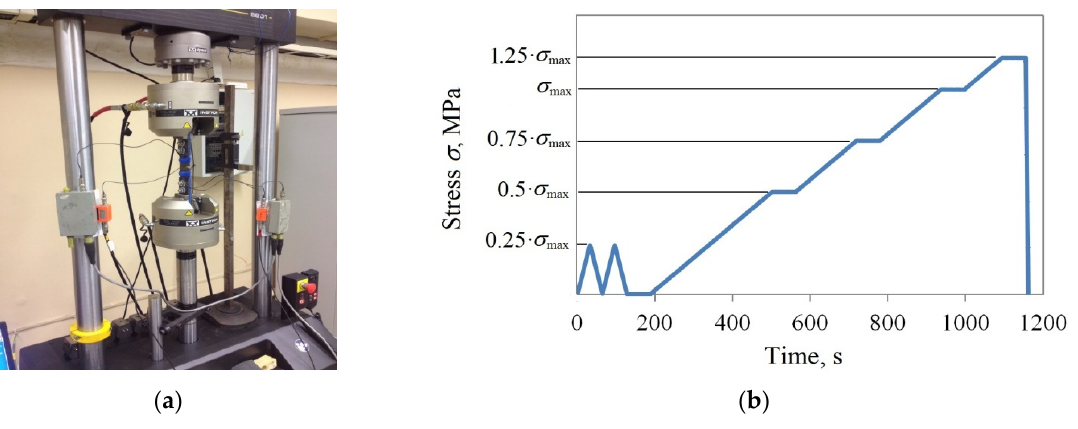
Figure 1. Experimental setup ( a ) and loading diagram ( b ).